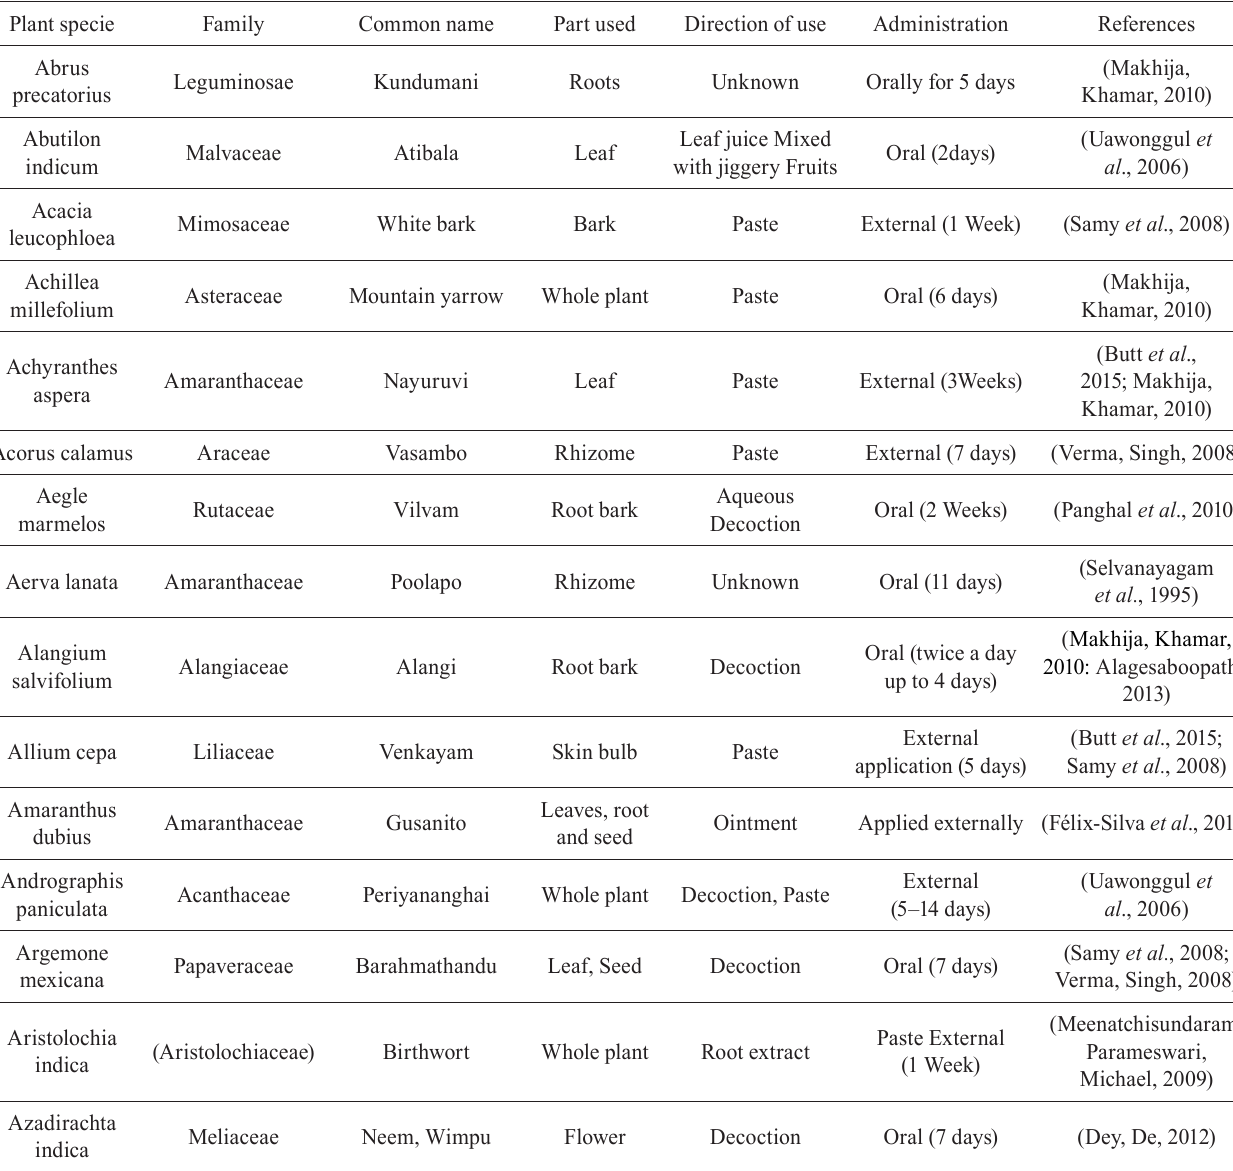
TABLE I - T raditionally used plants for Snakebite